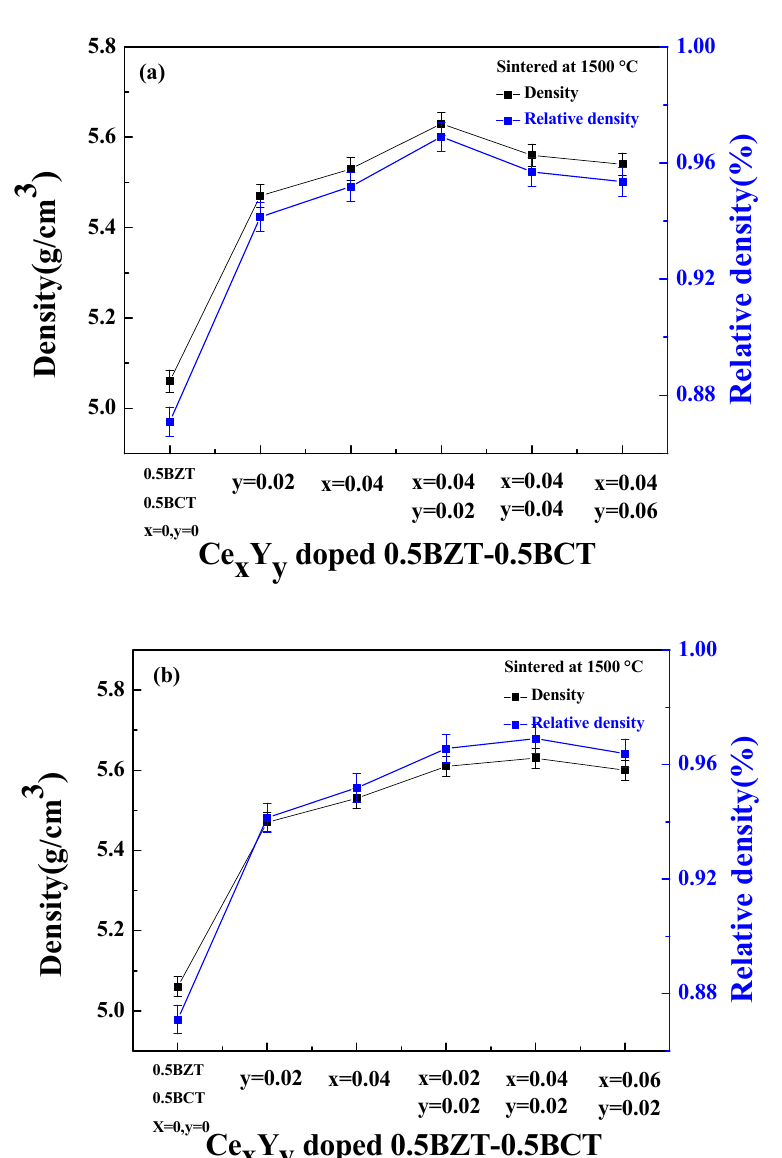
Figure 4. The density of Ce and Y doped BCZT ceramics. ( a ) for the Ce 0.04 Yy doped BCZT ceramics, ( b ) CexY 0.02 doped BCZT ceramics, respectively. ( b ) CexY 0.02 doped BCZT ceramics,